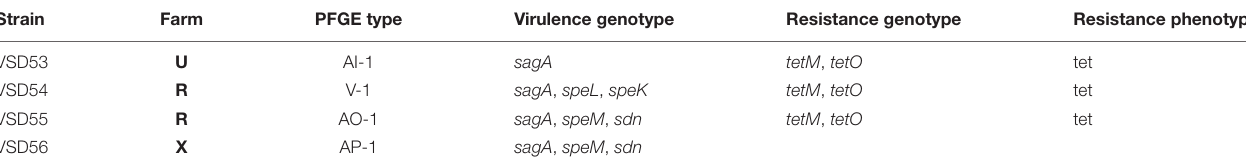
Table 1 . Two or more strains share six PFGE patterns, and 31